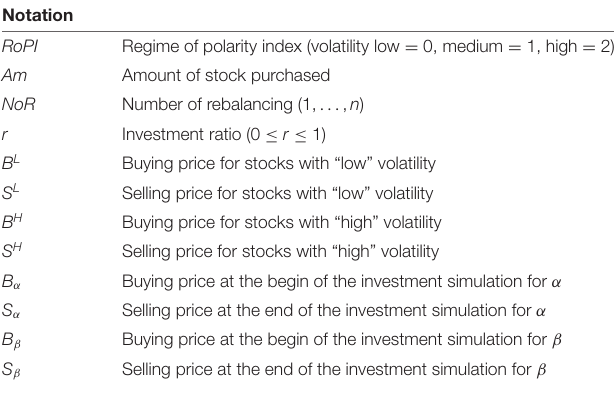
TABLE 2 | Notation of investment